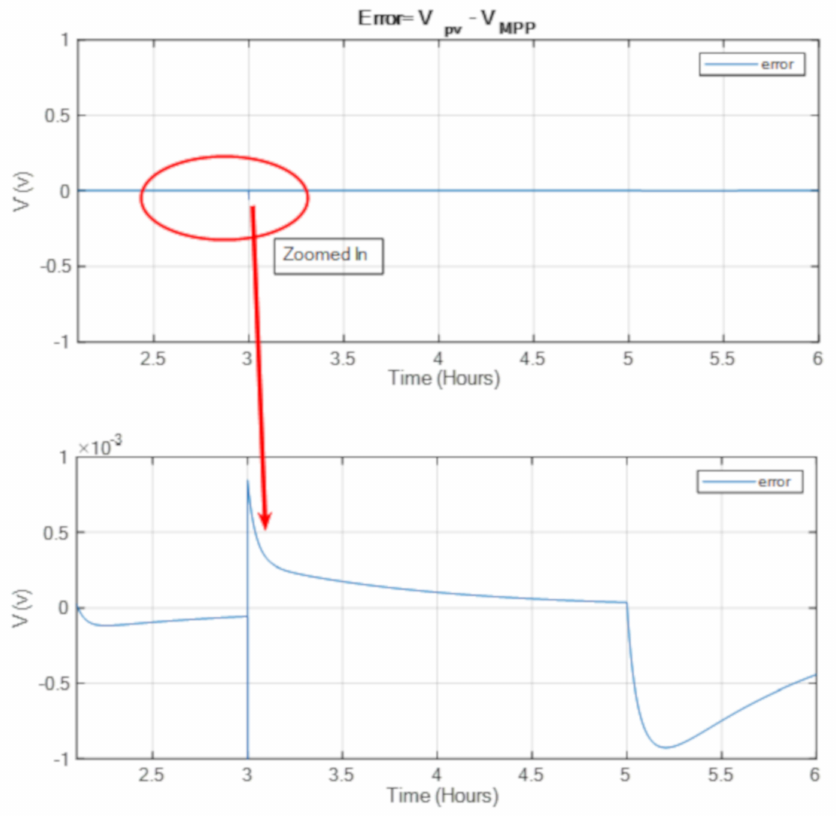
Figure 14. Error = V PV - (cid:101) V MPP .